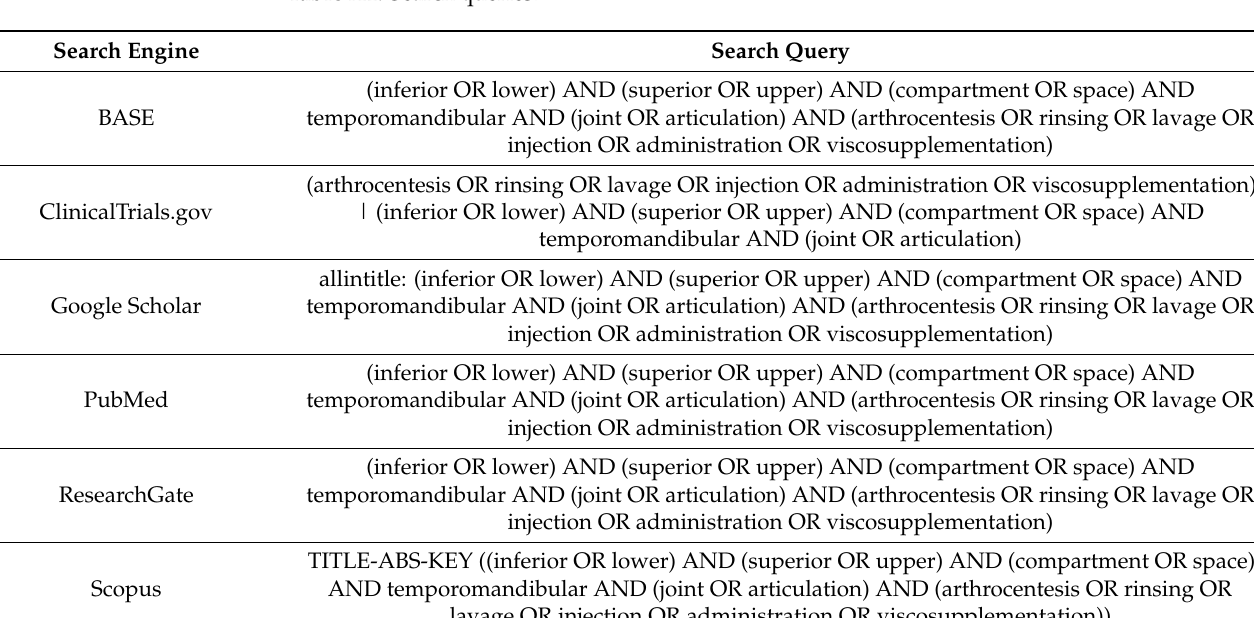
Table A1. Search